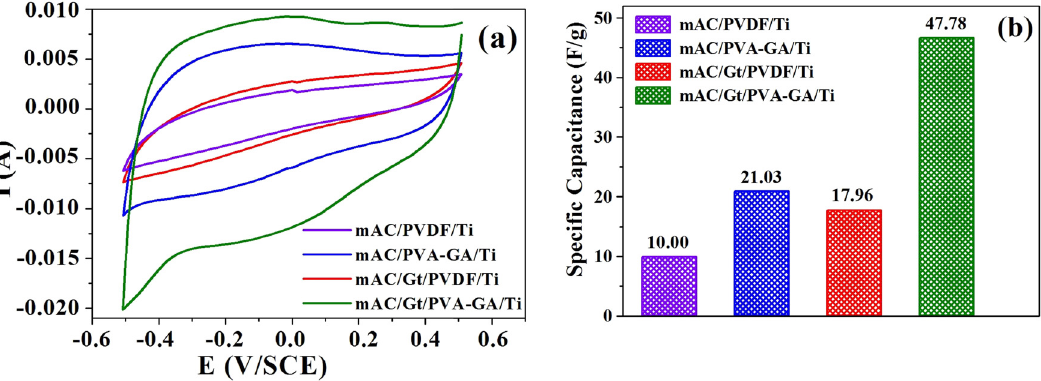
Figure 5: ( a ) Cyclic voltammograms of the electrodes in 200 ppm NaCl solution at a scan rate of 5 mV · s − 1 and ( b ) speci fi c capacitance of the